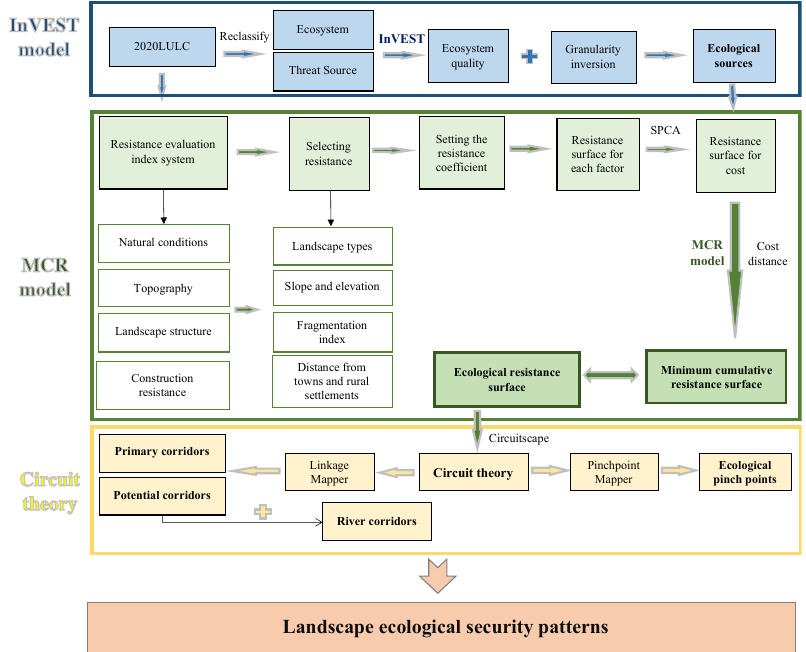
Figure 2. Research Procedure.